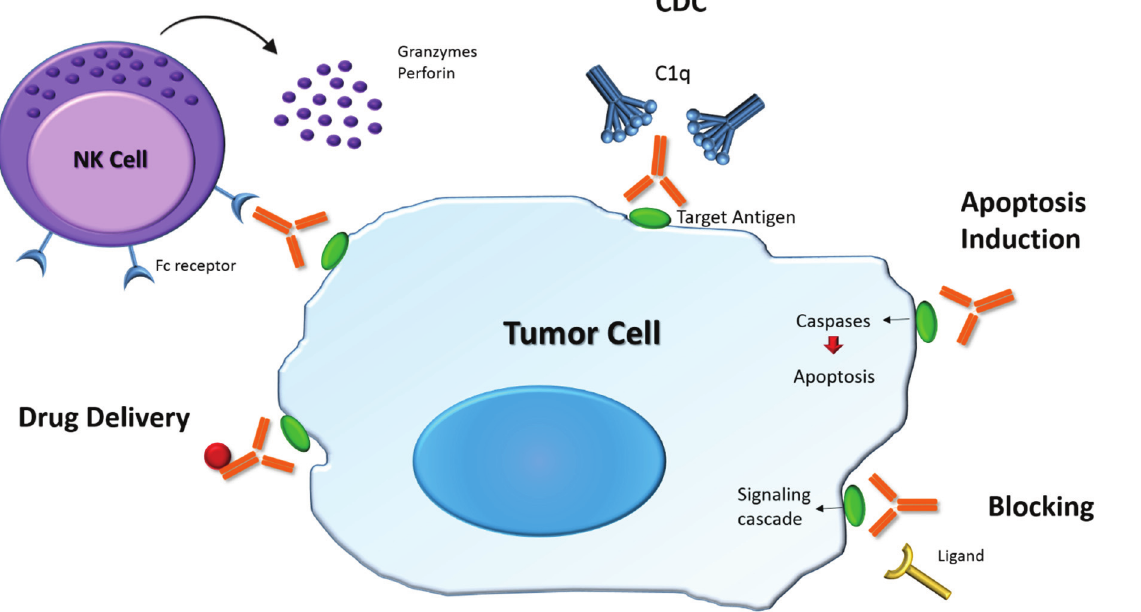
Figure 4. Main functions of therapeutic mAb. mAb can induce antibody dependent cell-mediated cytotoxicity (ADCC) by inducing the release of cytotoxic granules in effector cells (e.g., NK cells). It can also induce complement dependent cytotoxicity (CDC), which starts with the binding of C1q to the antibody triggering the complement cascade. mAb can induce apoptosis as well by activating caspases. In addition, mAb can block receptor/ligand interactions preventing signaling cascade activation, as well as specifically deliver drugs into tumor